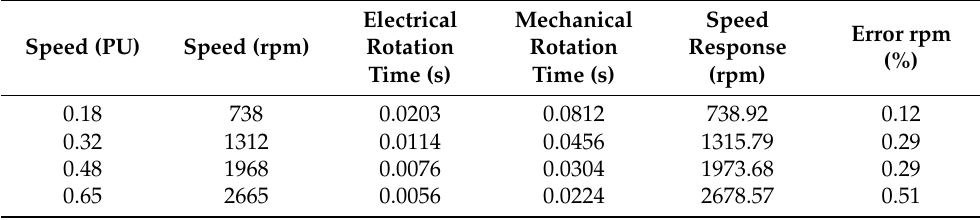
Table 2. Speed calculations from rotor position response.